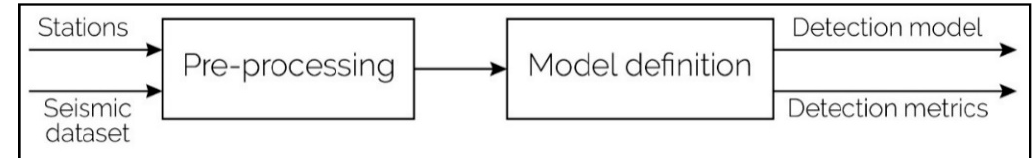
Figure 5. Block diagram of the classification process.